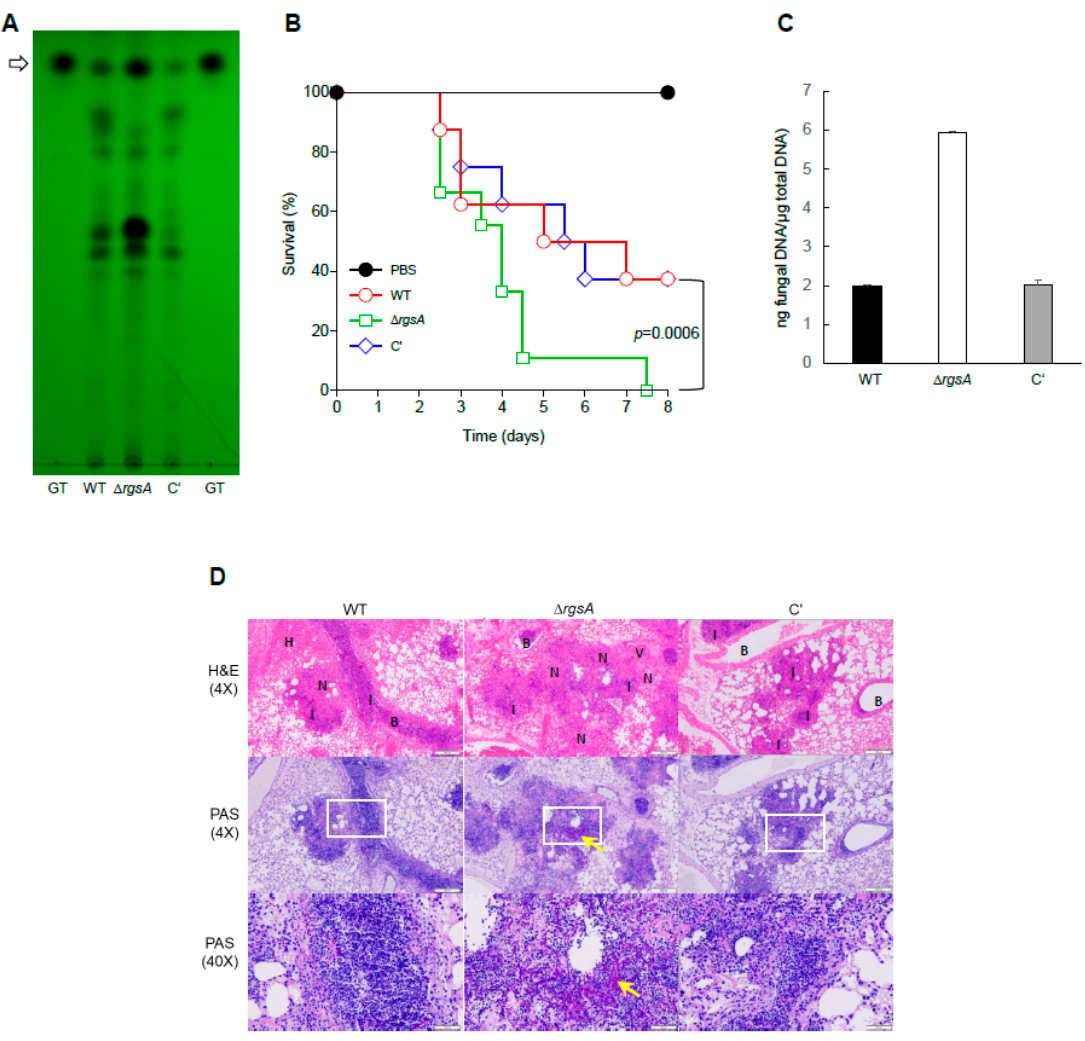
Figure 5. The role of RgsA in GT production and virulence. ( A ) Determination of GT production in WT, Δ rgsA , and C ′ strains. The culture supernatant of each strain was extracted with chloroform and subjected to TLC. The arrow indicates GT. ( B ) Survival curve of mice infected with WT, Δ rgsA , and C ′ strains (n = 10/group). ( C ) Fungal burden in the lung tissue by RT-PCR method. ( D ) Lung sections from infected WT, Δ rgsA , and C ′ strains were stained with Hematoxylin and Eosin (H&E) or periodic-acid Schiff (PAS). Yellow arrow indicates highly-dense fungal hyphae visualized by magenta color. H: hemorrhage; B: bronchiole; I: inflammation; N: necrosis; V: blood vessel. Scale bars = 200 µm (4×) and 50 µm (40 ×).